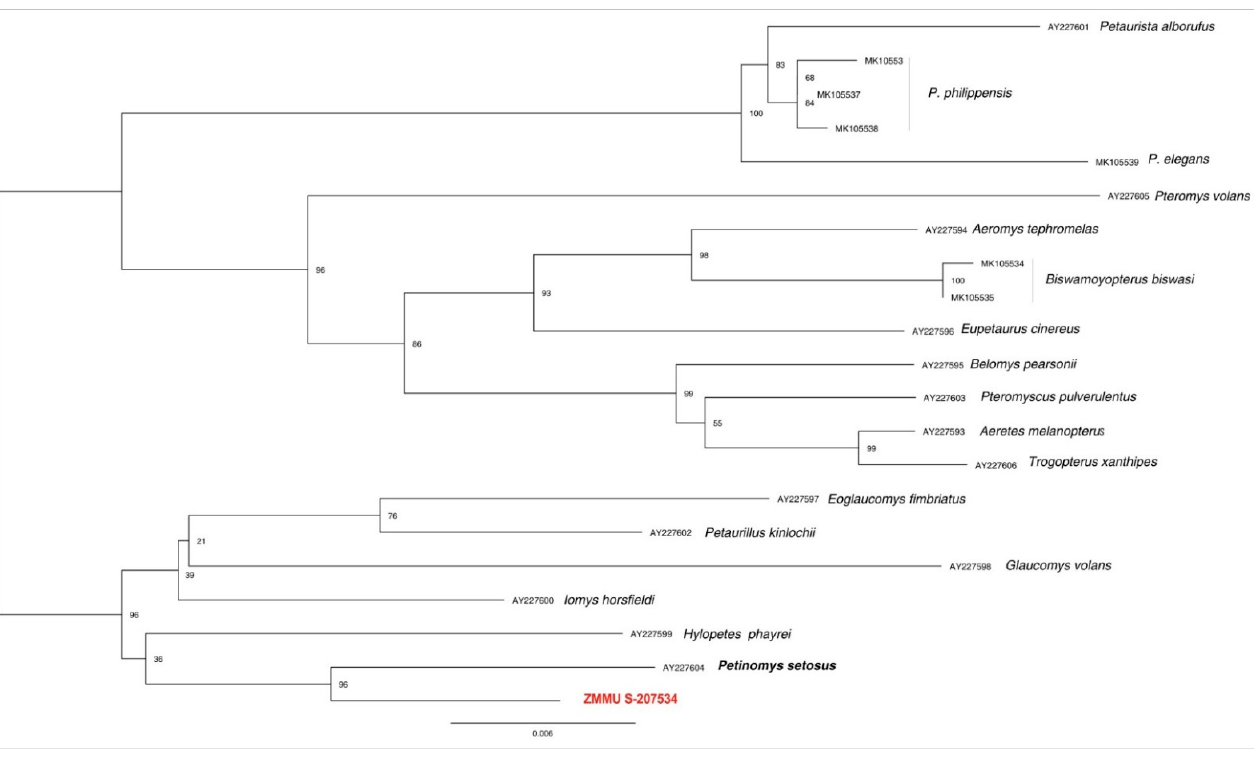
Figure 7. Phylogenetic ML tree for the Pteromyini tribe reconstructed from alignment of the nuclear gene IRBP. Numbers on tree nodes indicate bootstrap values.